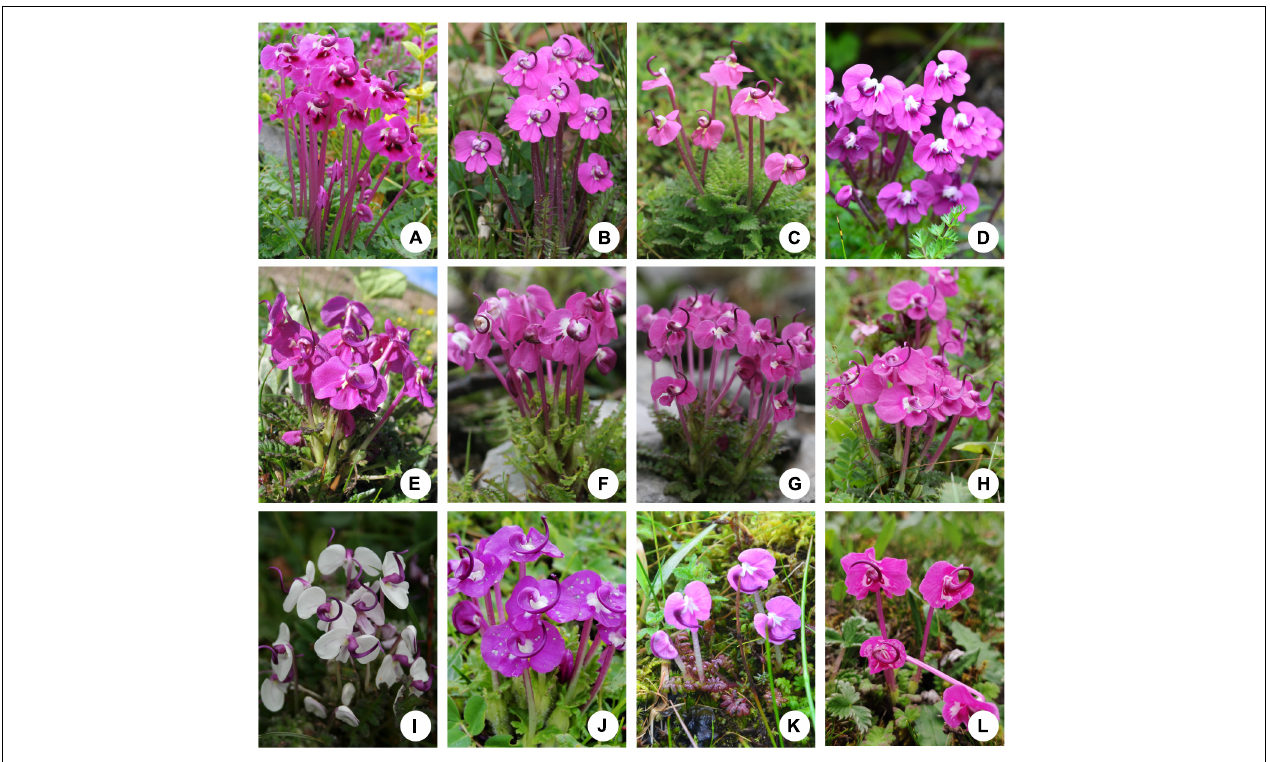
FIGURE 1 | Field photos of 11 species of the Pedicularis siphonantha complex and Pedicularis delavayi , (A) Pedicularis tenuituba H. L. Li; (B) Pedicularis leptosiphon H. L. Li; (C) Pedicularis dolichosiphon (Hand.-Mazz.) H. L. Li; (D) P. siphonantha D. Don; (E) Pedicularis sp. 2 from Jiaozi snow mountain; (F) Pedicularis milliana W. B. Yu, D. Z. Li, and H. Wang; (G) Pedicularis sp. 1 from Ganheba, Lijiang; (H) Pedicularis sigmoidea Franch. ex Maxim; (I) Pedicularis variegata H. L. Li; (J) Pedicularis dolichantha Bonati; (K) Pedicularis humilis Bonati. (L) Pedicularis delavayi Franch. ex